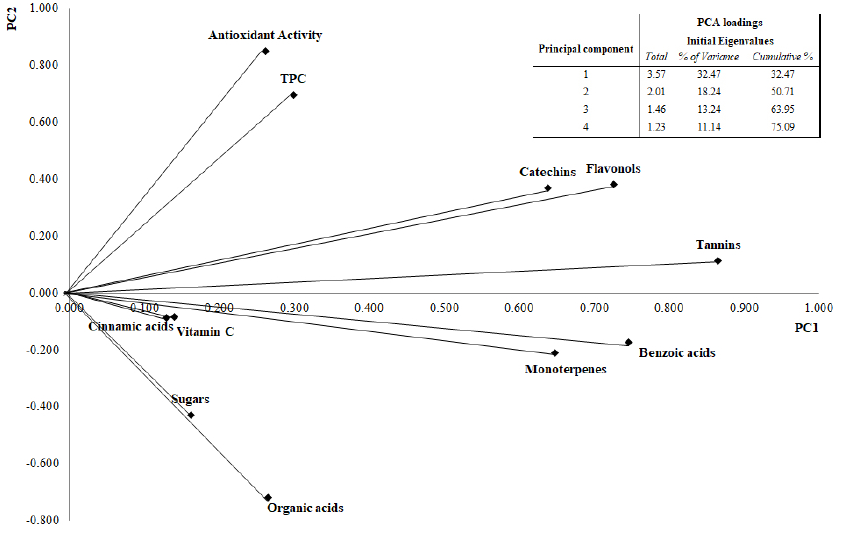
Figure 9. PCA loading plot of considered